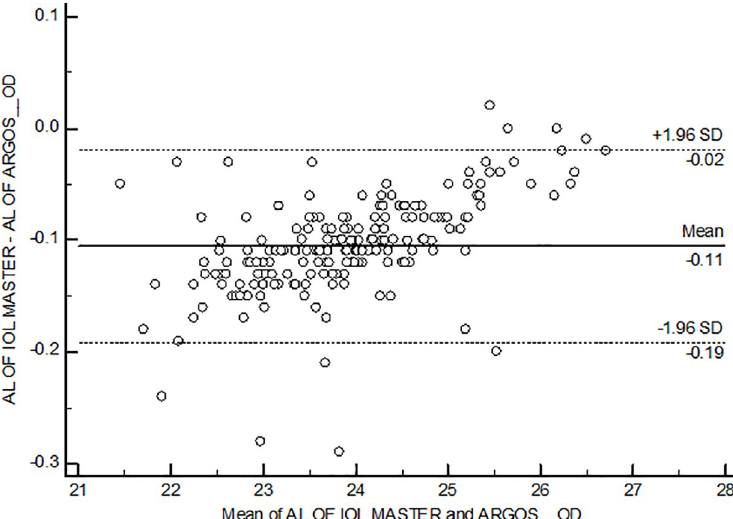
Fig 4. Bland-Altman plot for agreement between axial length using Argos and IOL master biometers. AL-Axial length; OD–Right eye.